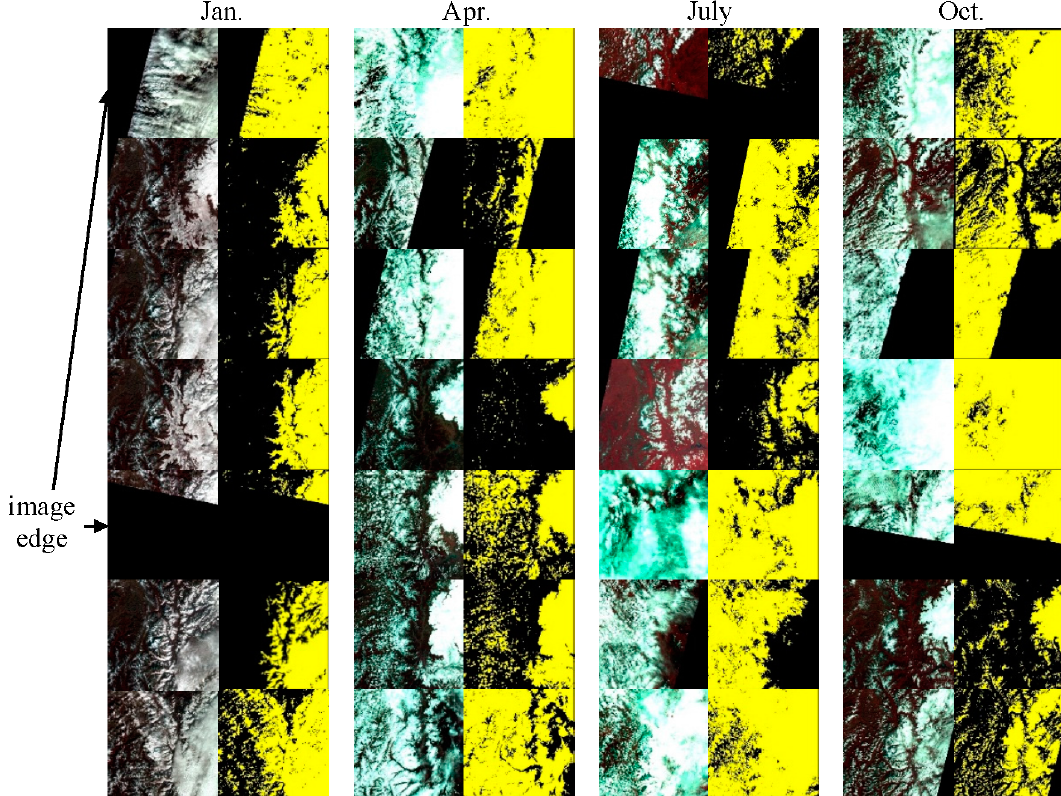
Figure 8. Cont. Figure 8.